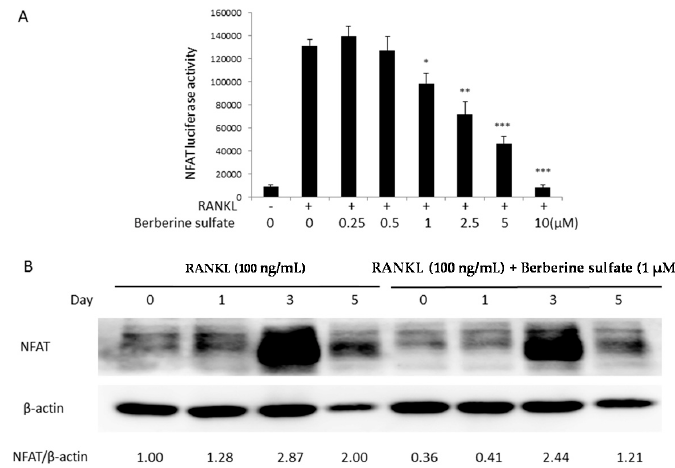
Figure 5. Berberine sulfate suppressed RANKL-induced NFAT activity. ( A ) RAW264.7 cells were stably transfected with an NFAT-dependent transcriptional luciferase reporter construct and then pretreated with indicated concentration of berberine sulfate for 1 h, prior to the addition of RANKL (50 ng/mL) for 24 h. The cells were harvested, and the luciferase activity was measured ( n = 6). “ − “ means RANKL untreated; “+” means RANKL treated. * p < 0.05, ** p < 0.01,*** p < 0.001 compared with untreated control; ( B ) BMM cells were pretreated with berberine sulfate for 1 h, followed by RANKL (100 ng/mL) stimulation for indicated times. The cell lysates were probed for NFATc1 protein levels using Western blot analysis.